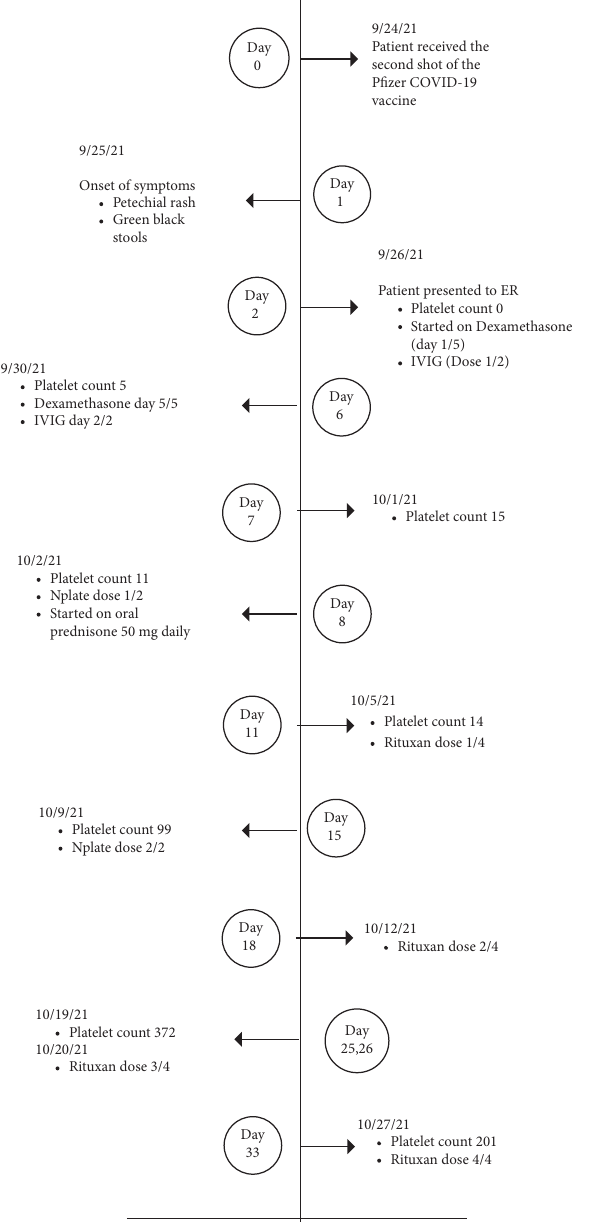
Figure 1: The timeline of the patient’s treatments and her platelet counts.